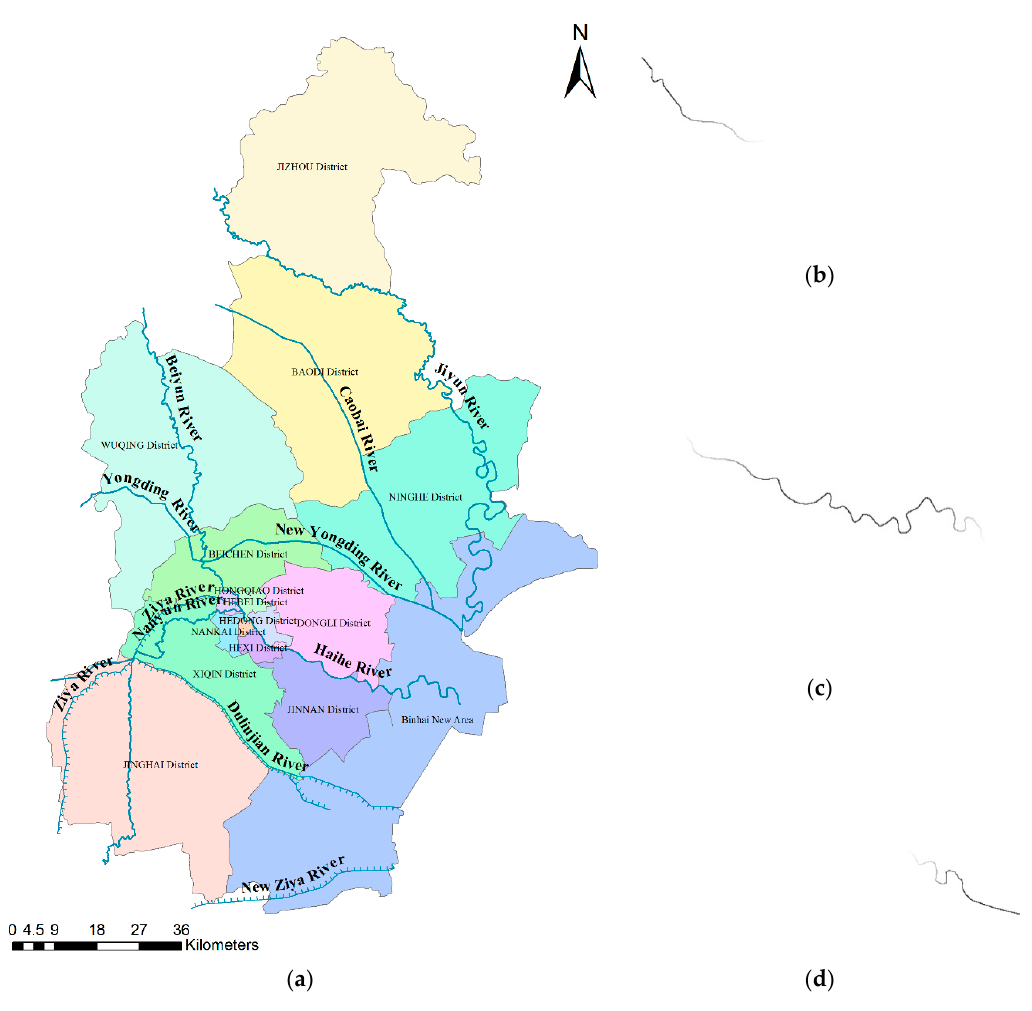
Figure 9. Fuzzy interior division of the Haihe River, adapted from [33]: ( a ) Tianjin City river network; ( b ) upstream section; ( c ) midstream section; and ( d ) downstream section.